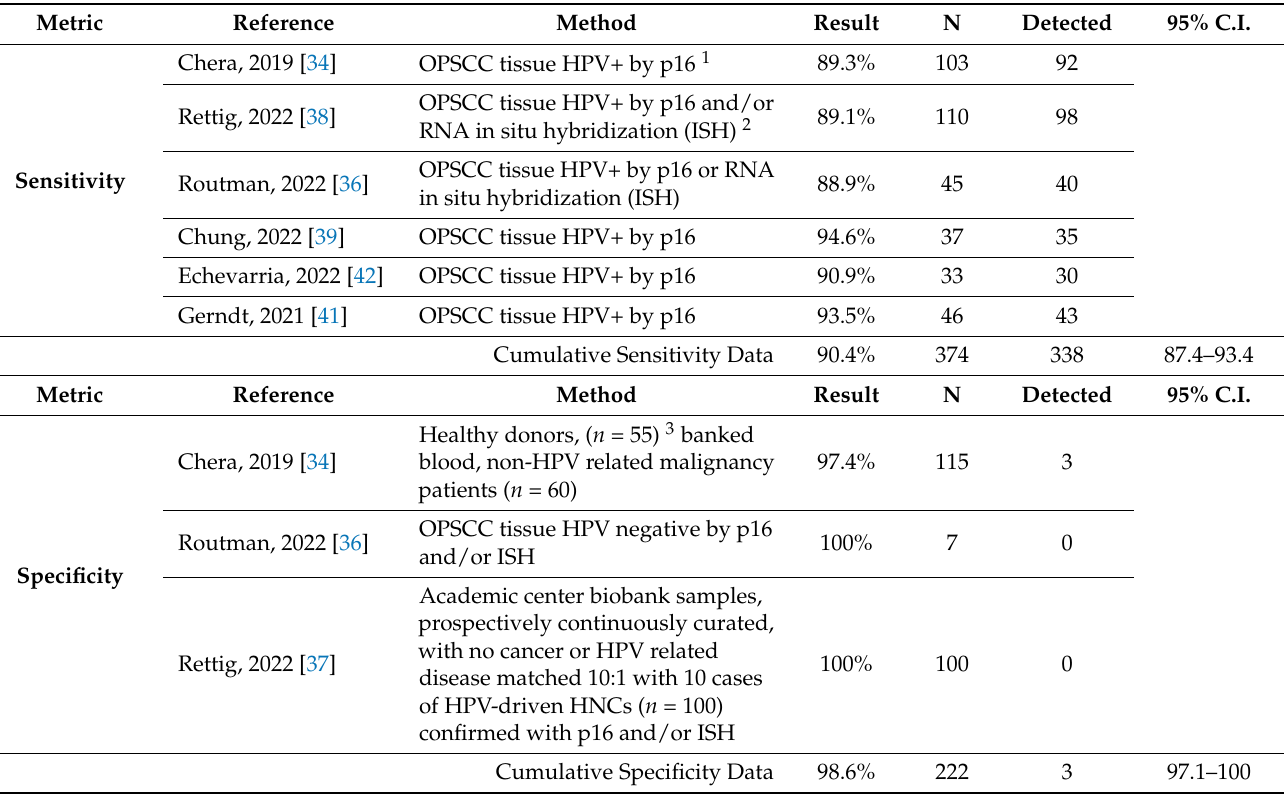
Table A2. NavDx sensitivity and specificity data from published studies evaluating the tumor tissue modified viral HPV-DNA in patients with OPSCC-driven oropharyngeal cancer, alongside control populations of patients with non-HPV-driven cancers and biobank samples from individuals not known to have HPV-related